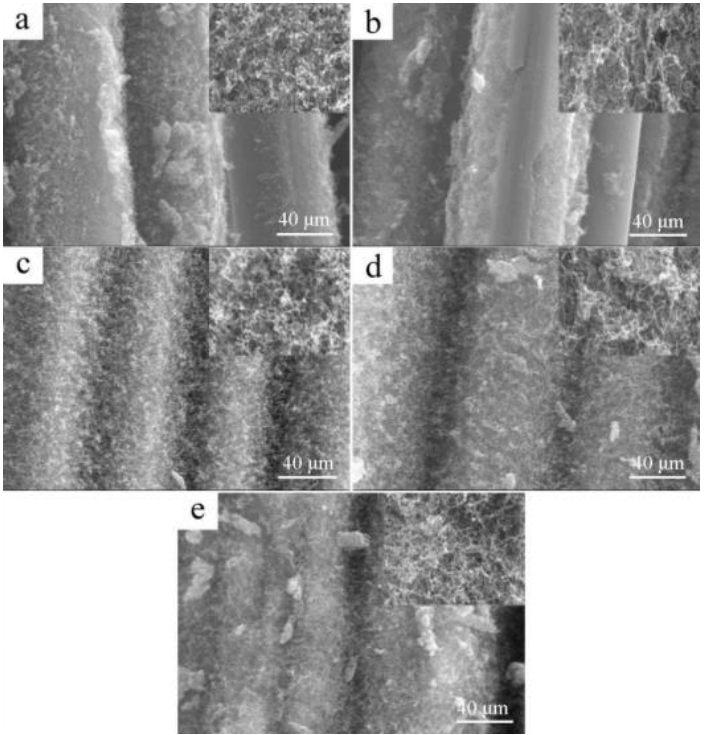
Figure 7. SEM micrographs of CNTs/CF multiscale reinforcements prepared under different growth atmospheres, the flow rate of H 2 to C 2 H 2 : ( a ) 0:0.3; ( b ) 0.15:0.3; ( c ) 0.3:0.3; ( d )0.6: 0.3 and ( e ) 0.9:0.3. The moving speed of carbon fibers was 4 cm/min.